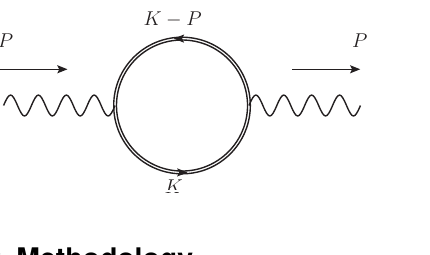
Figure 2. One loop photon